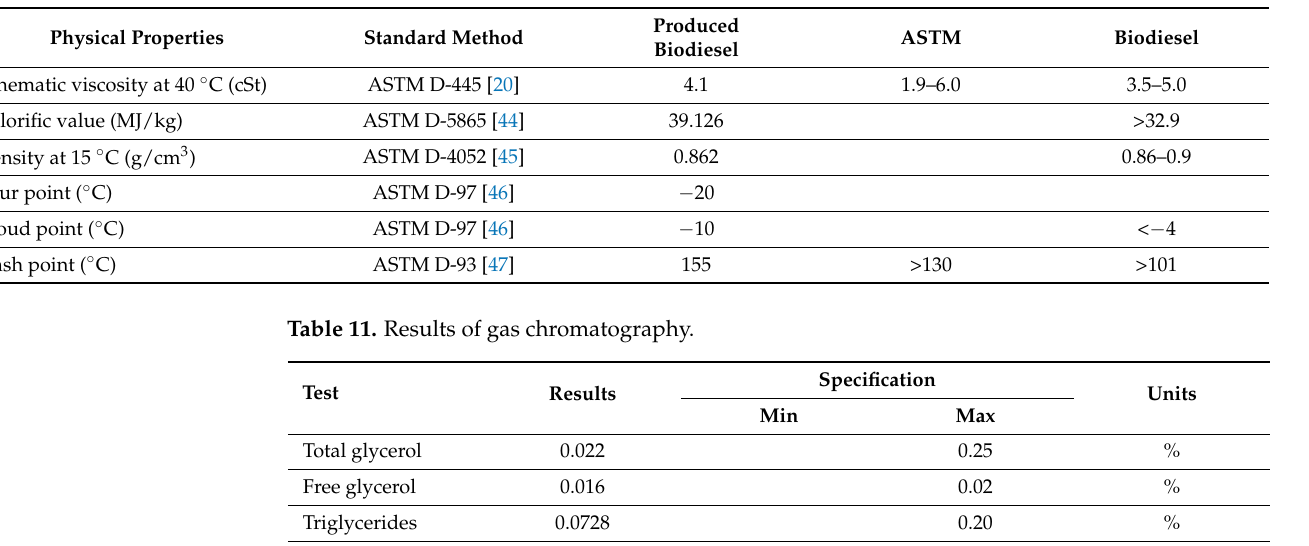
Table 10. Optimal biodiesel sample physicochemical properties.